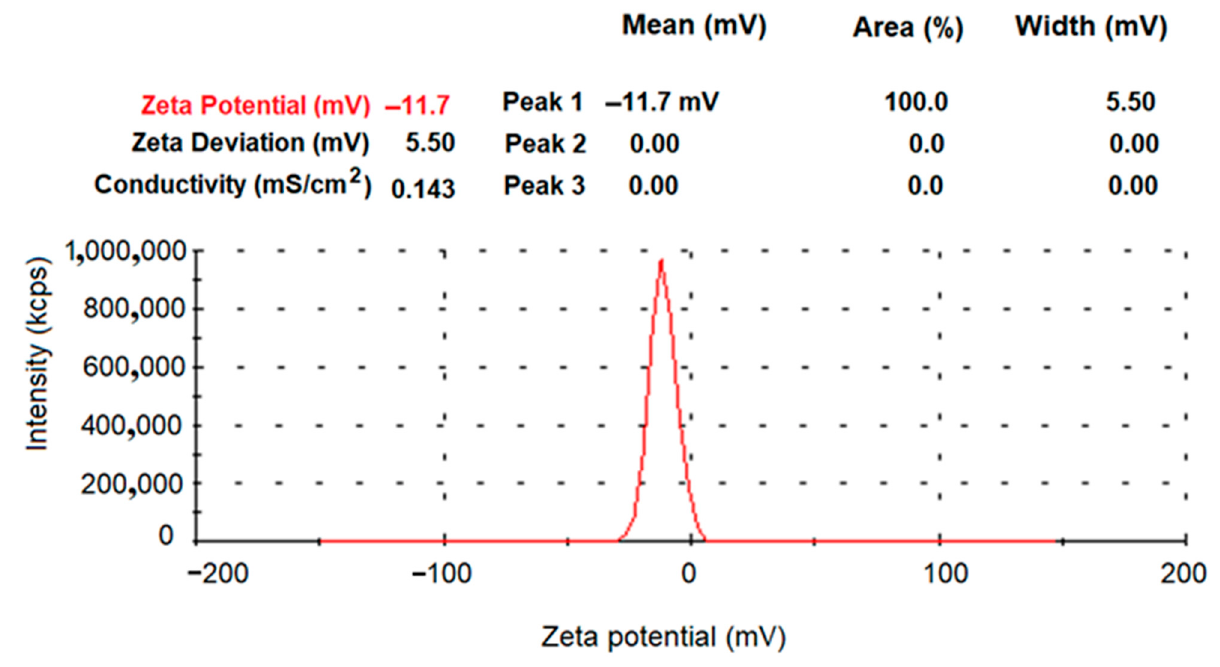
Figure 10. Zeta potential distribution for A-IONPs sample.